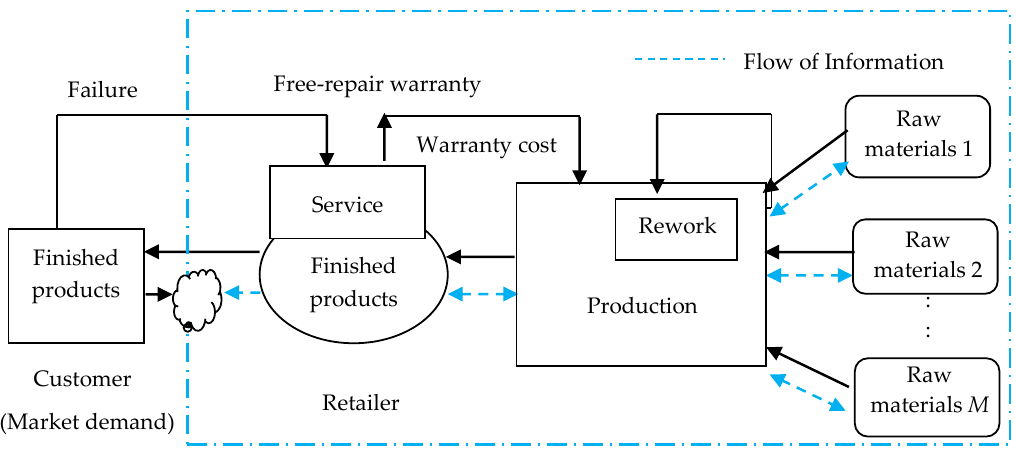
Figure 1. Schematicoftheproduction–inventorymodelwithvariousactivities. Source: modifiedfrom[57]. Figure 1. Schematic of the production–inventory model with various activities. Source: modified from Theretailercanmakeorderingdecisions, butpriceisnotundertheircontrol. [57].